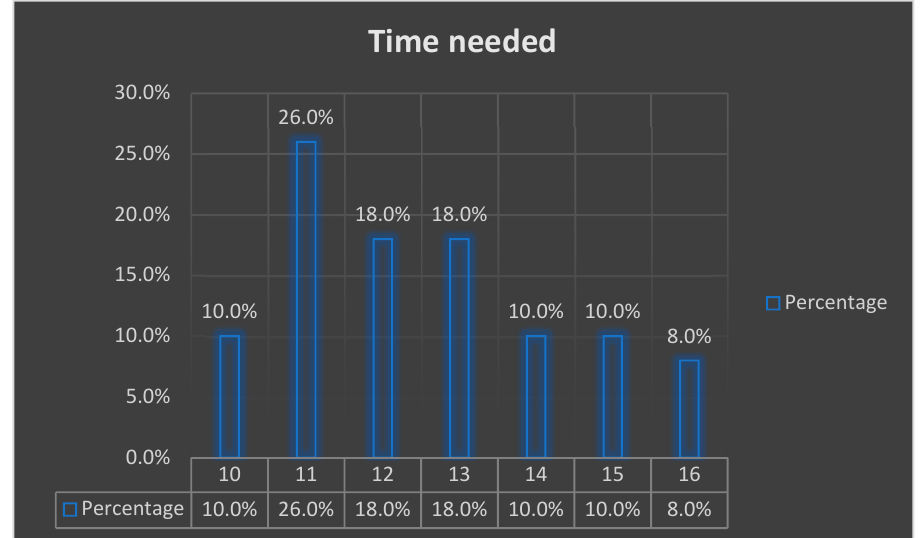
Figure 6. DSMBD—situation S1-1.